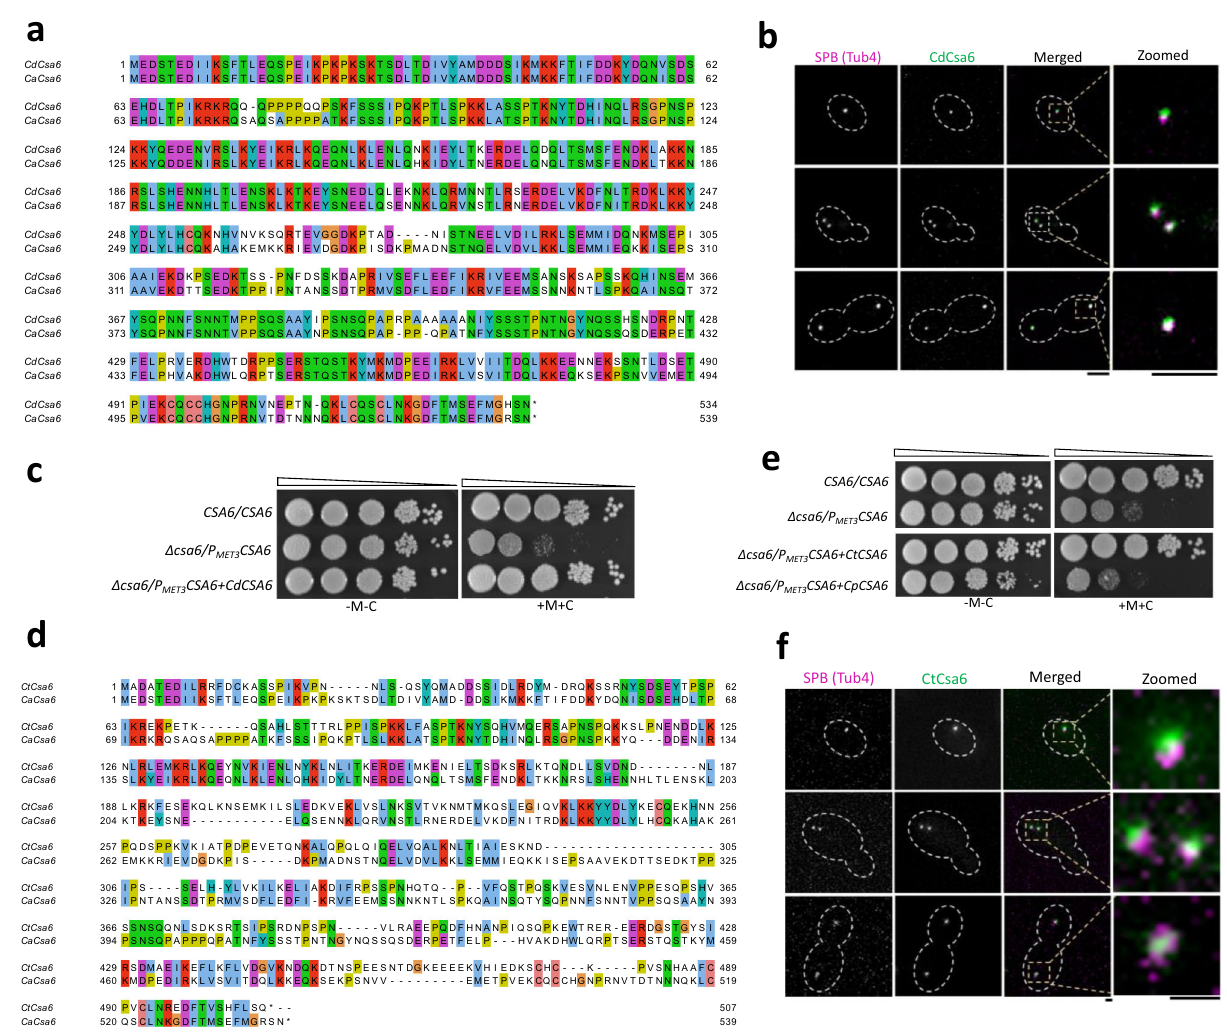
Fig. 7 Functional complementation of CaCsa6 by its homologs in related species. a Pair-wise alignment of amino acid sequences of Csa6 proteins in C. albicans (CaCsa6) and C. dubliniensis (CdCsa6) by Clustal Omega, visualized using Jalview. b CdCsa6 localizes to the SPB. Representative micrographs showing CdCsa6GFP localization at different cell cycle stages in CaPJ300. Tub4mCherry was used as an SPB marker. Scale bar, 3 µ m. c CdCsa6 functionally complements CaCsa6. Ten-fold serial dilutions of SN148 ( CSA6/CSA6 ), CaPJ301( CSA6 PSD ) and CaPJ302 ( CSA6 PSD expressing CdCSA6 ), starting from 10 5 cells were spotted on agar plates with permissive (YPDU-Met-Cys) or repressive (YPDU + 5 mM Met and 5 mM Cys) media and incubated at 30 °C for two days; N = 3. d Pair-wise protein sequence alignment of Csa6 of C. tropicalis (CtCsa6) and CaCsa6. e CtCsa6 but not CpCsa6 (Csa6 of C. parapsilosis ) functionally complements CaCsa6. Spot dilution analysis of SN148 ( CSA6/CSA6 ), CaPJ301( CSA6 PSD ), CaPJ303 ( CSA6 PSD expressing CtCSA6 ) and CaPJ304 ( CSA6 PSD expressing CpCSA6 ). Ten-fold serial dilutions, starting from 10 5 cells were spotted on permissive or repressive media; N = 3. f Representative micrographs showing constitutive localization of CtCsa6 at the SPBs in CaPJ303 ( CSA6 PSD expressing CtCSA6 ) under permissive conditions. SPBs are marked using Tub4mCherry. Scale bar, 1 µ